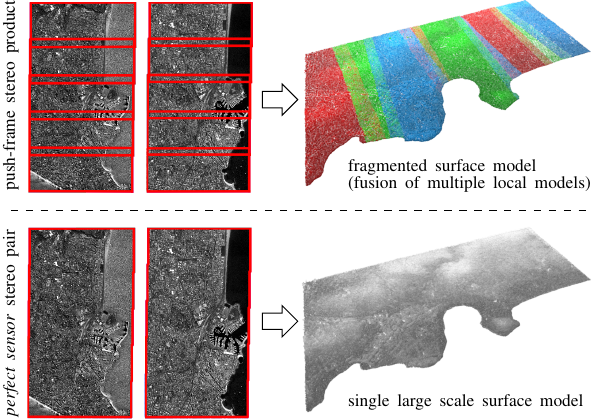
Figure 1. We combine the multiple images of each strip acquired by the push-frame system to produce large scale mosaics. The resulting perfect sensor images and their localization models can be used to greatly simplify the task of large scale stereo reconstruction from push-frame satellite